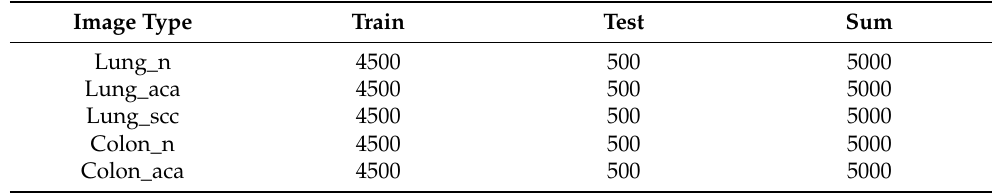
Table 3. Data distribution of samples in the five categories of LC25000.